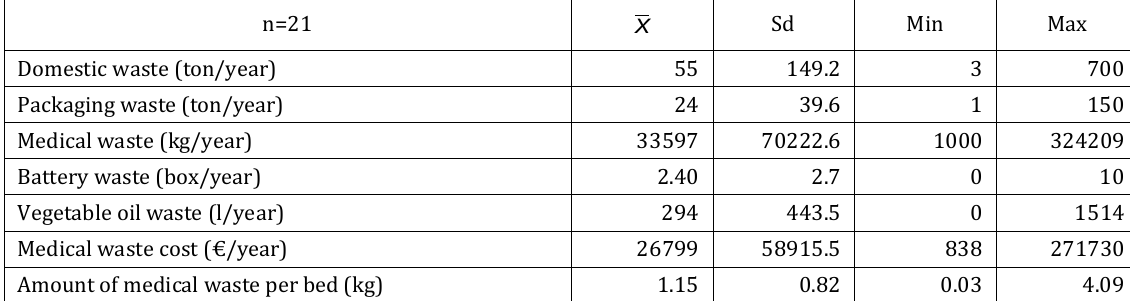
Table 3. Distribution and cost of waste